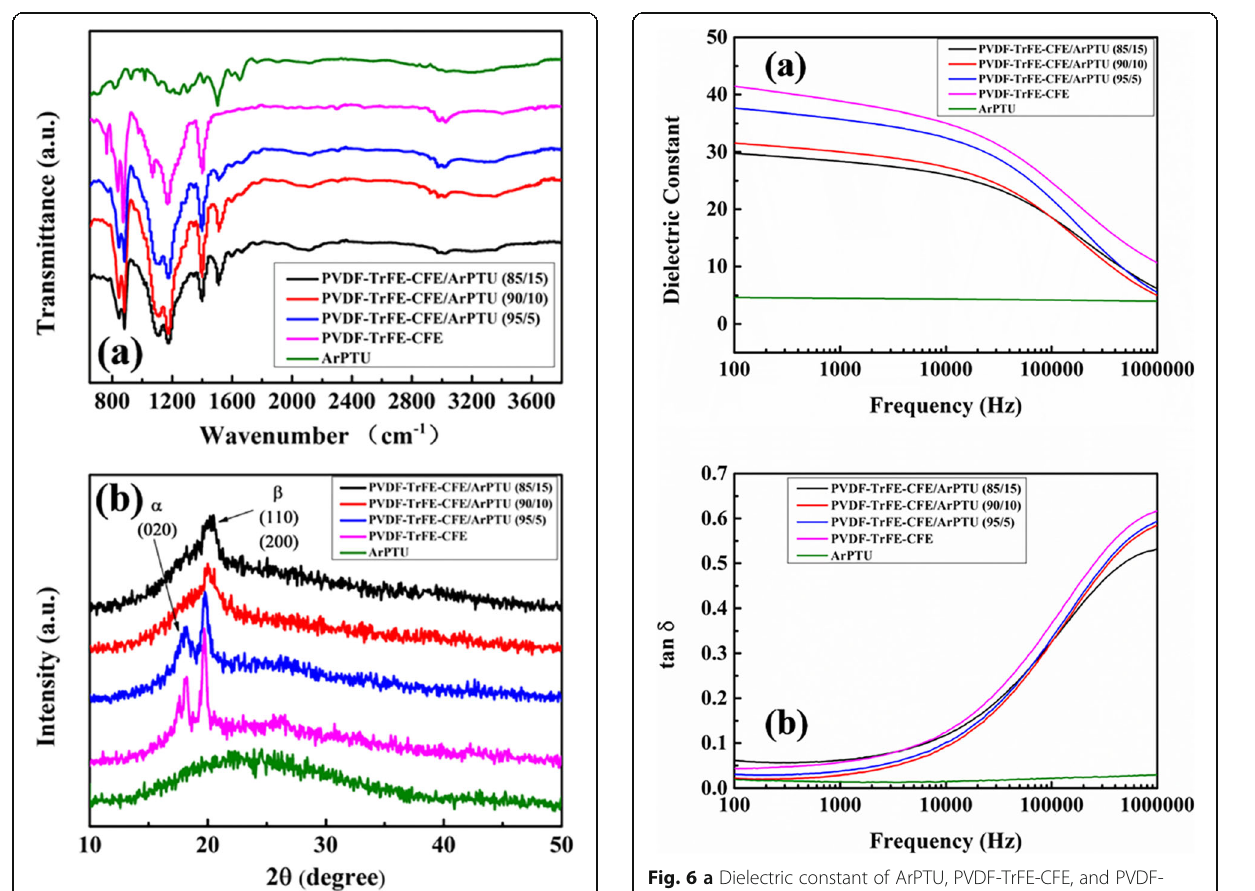
Fig. 5 a The FTIR curves of PVDF-TrFE-CFE/ArPTU composite films with different composite ratios. b The XRD curves of PVDF-TrFE-CFE/ ArPTU composite films with different composite ratios